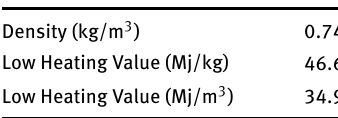
Table 3: Properties of